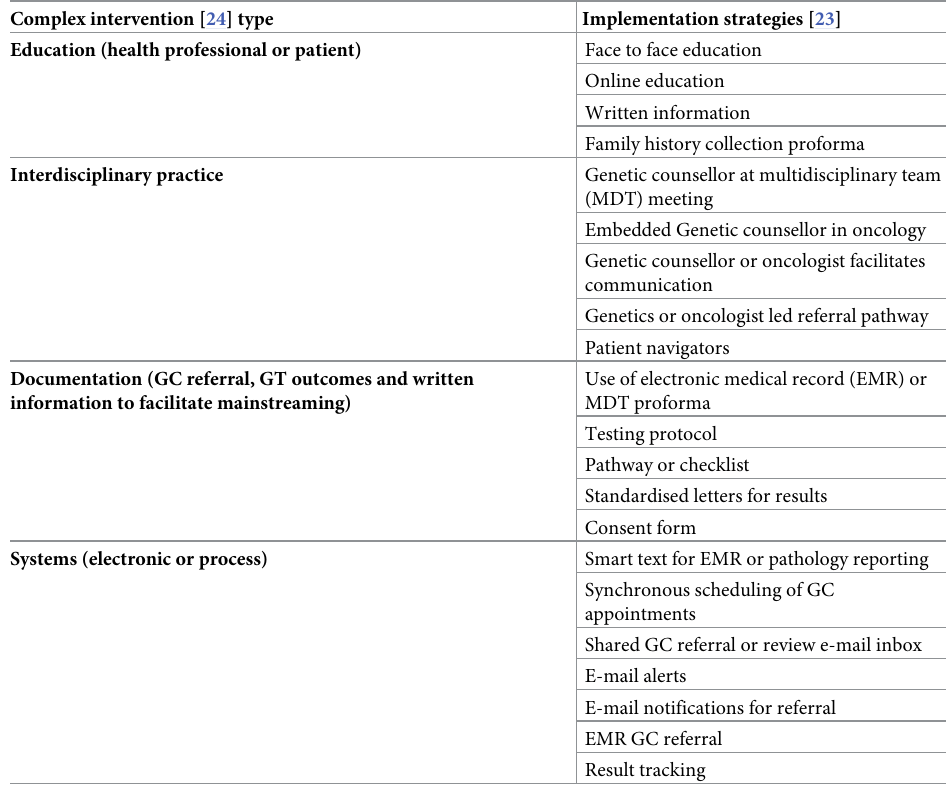
Table 1. Classification of intervention components into four distinct